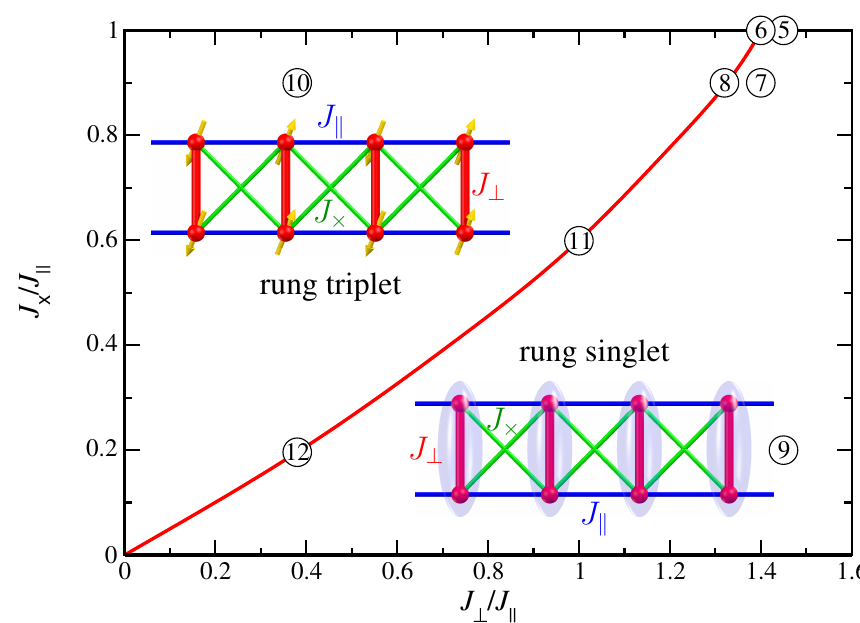
Figure 1: Ground-state phase diagram of the frustrated spin ladder, as established by a range of numerical methods [ 36–42 ] . The system shows only two phases, rung-singlet and rung- triplet, which are separated by a quantum phase transition (red line). In the inset schematics, the ladder sites (spheres) host S = 1 / 2 quantum spins and the Heisenberg couplings between spins are specified by the parameters J ⊥ for the ladder rungs, J (cid:107) for the ladder legs (blue), and J × for the cross-plaquette couplings (green), which we take to be symmetrical. Purple rungs with ellipses represent rung-singlet spin states and red rungs with two parallel spins represent rung triplets. The numbered circles designate those points in the phase diagram for which we present thermodynamic results, each number matching that of the corresponding figure in Sec.